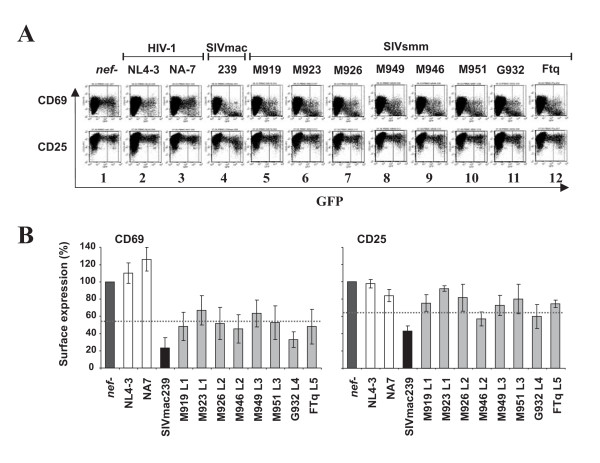
Modulation of T activation by SIVsmm nef alleles. (A) PBMCs were transduced with replication-competent VSV G pseudotyped HIV-1 particles expressing either GFP alone (panel 1) or together with the HIV-1 NL4-3 and NA7 (panels 2 and 3), 239 wt (panel 4) or SIVsmm nef alleles (panels 5 to 12) and stained for CD69 and CD25 expression. Similar results were obtained in two independent experiments. (B) CD69 and CD25 expression levels on PBMCs infected with HIV-1 constructs coexpressing eGFP and the indicated nef alleles are shown relative to those measured on T cells transduced with the nef defective control virus (100%). Values give averages ± SD derived from three independent experiments. The asterisks denote a statistical significance (P < 0.05) between HIV-1 and SIV Nef activity.